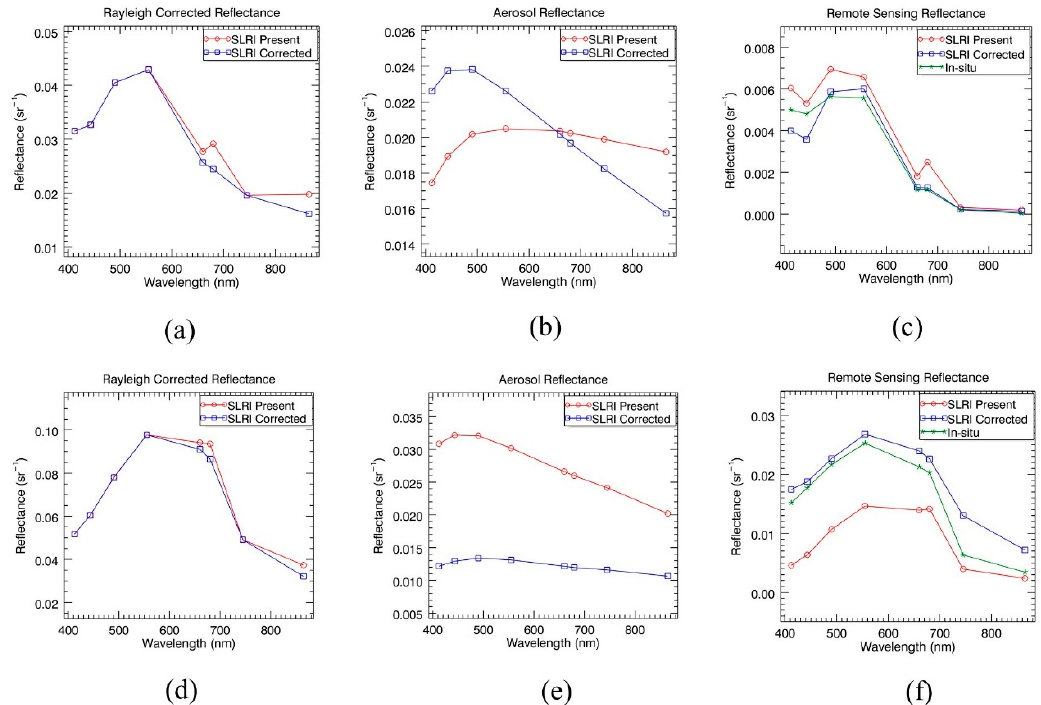
Figure 6. Spectra are presented for (( a ) and ( d )) Rayleigh-corrected reflectance ( ρ rc ); (( b ) and ( e )) aerosol reflectance ( ρ a ), and (( c ) and ( f )) remote sensing reflectance ( R rs ). The upper row figures ( a ), ( b ), and ( c ) are for Station 14, and the bottom row figures ( d ); ( e ); and ( f ) are for Station 16. In each figure, reflectance curves for both SLRI-present data before CIDUM (red) and data corrected by CIDUM (blue) are presented. For remote sensing reflectance (( c ) and ( f )), reflectance spectra for in situ measurements (green) are presented additionally.